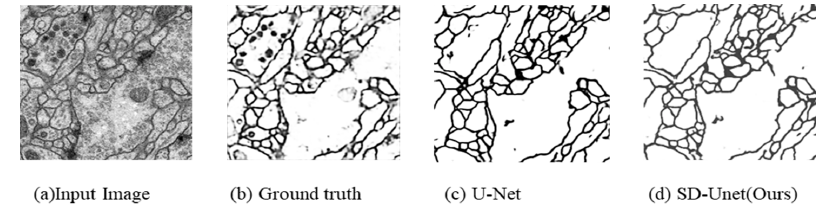
Figure 9. Sample Segmentation on electron microscopy dataset. ( a ) Input image; ( b ) Ground truth; (C) U-Net; (d) SD-Unet (Ours).